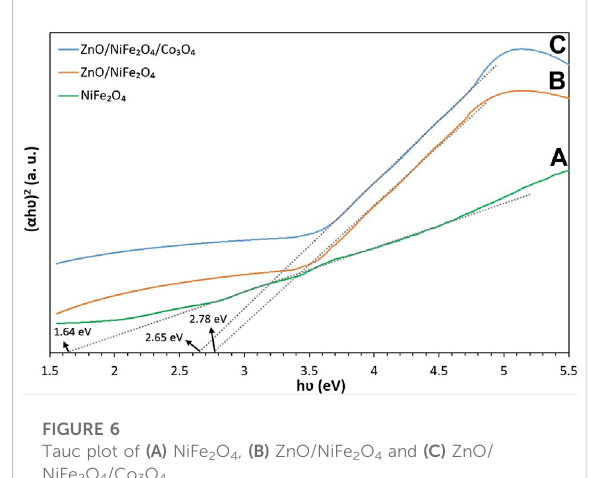
FIGURE 5 DRS analysis of (A) NiFe 2 O 4 , (B) ZnO/NiFe 2 O 4 and (C) ZnO/ NiFe 2 O 4 /Co 3 O 4 .